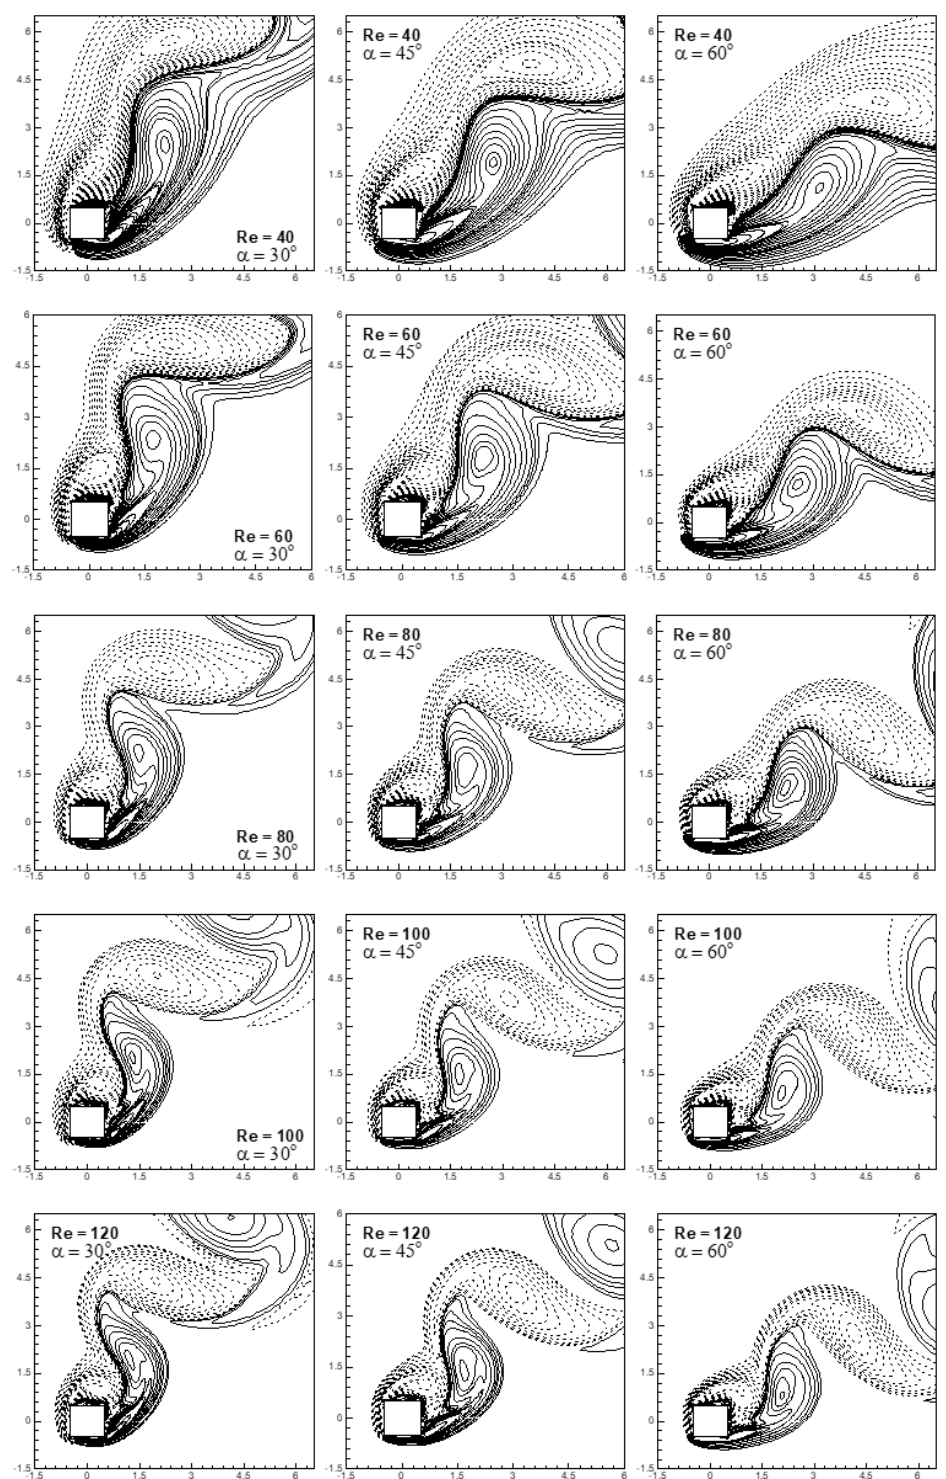
Figure 6. Instantaneous contours of vorticity for 30° ≤ α ≤ 60°, 40 ≤ Re ≤ 120 at Ri = 0. It is seen from Figure 5 that the large vortex attached to the top face of the square cylinder stretches toward the right face with an increase in free-stream orientation for the entire range of Reynolds number. Stretching of the attached vortex on the top face of the